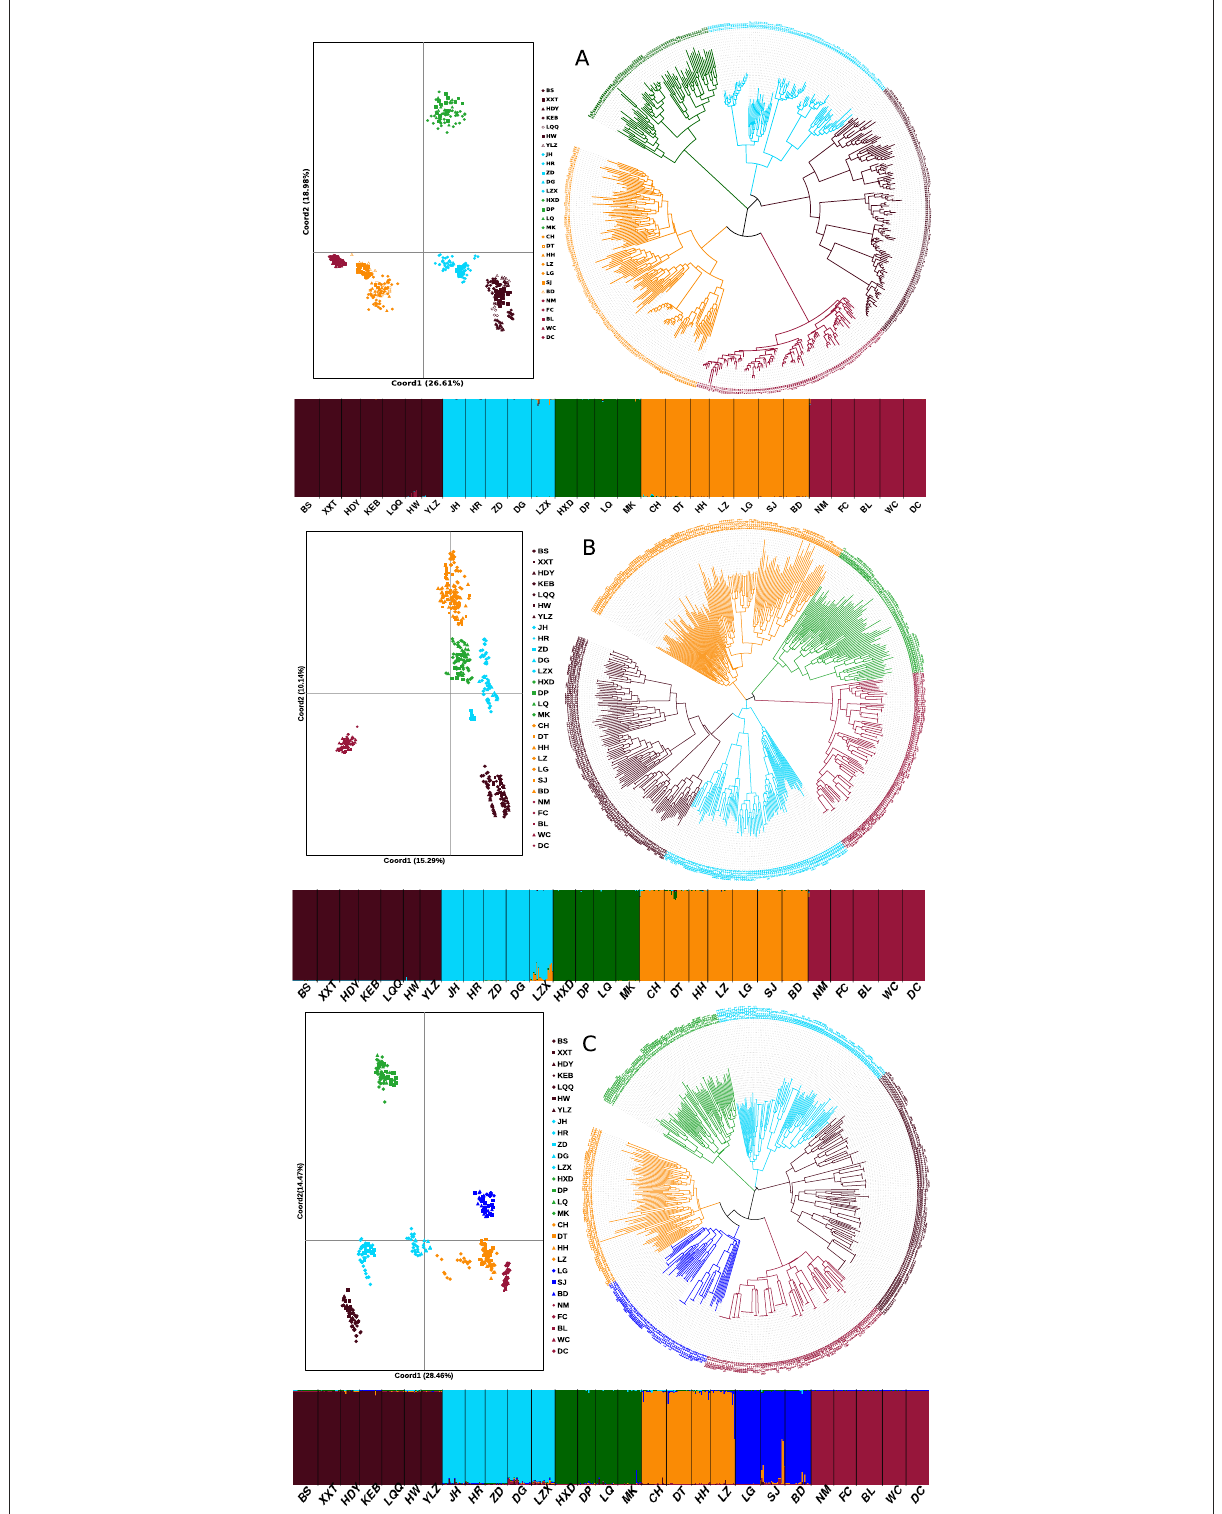
FIGURE3 Genetic structure of 28 Zizania latifolia populations based on STRUCTURE, principal coordinate analysis (PCoA), and neighbor joining tree (NJ). (A) based on all loci; (B) based on neutral loci; (C) based on outlier loci. The colors represent the clusters based on STRUCTURE analysis for the histograms and NJ